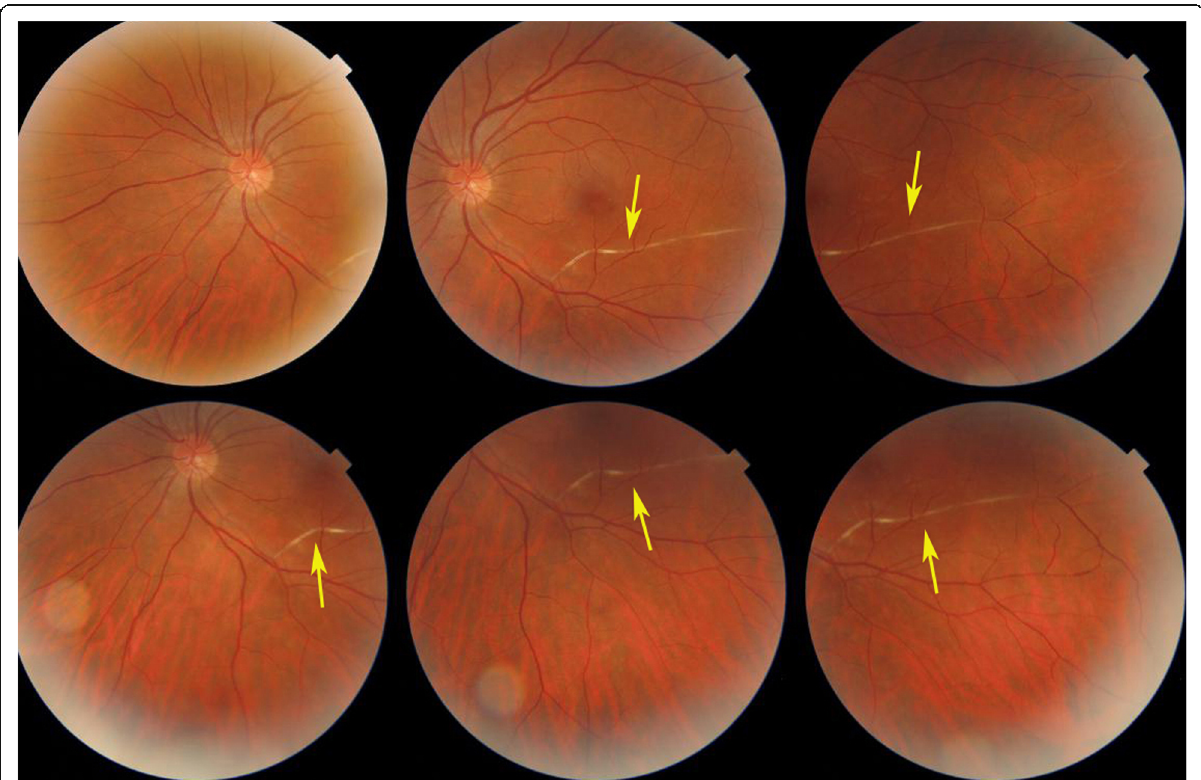
Fig. 2 White-yellow discoloration of the course of a branch artery from inferior arcade (arrows) in a case evolving since 4 months (case